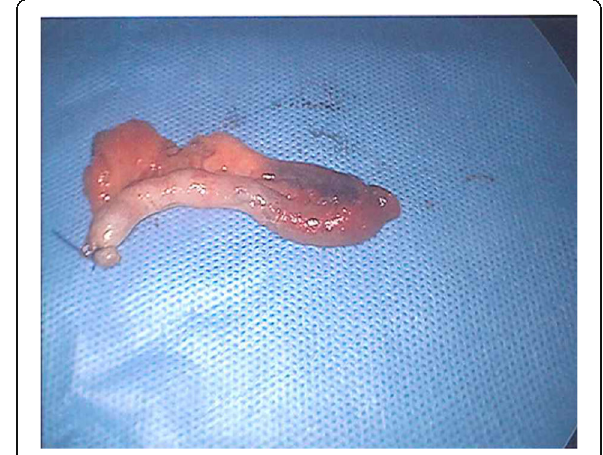
Fig. 3 Macroscopic view of the inflamed